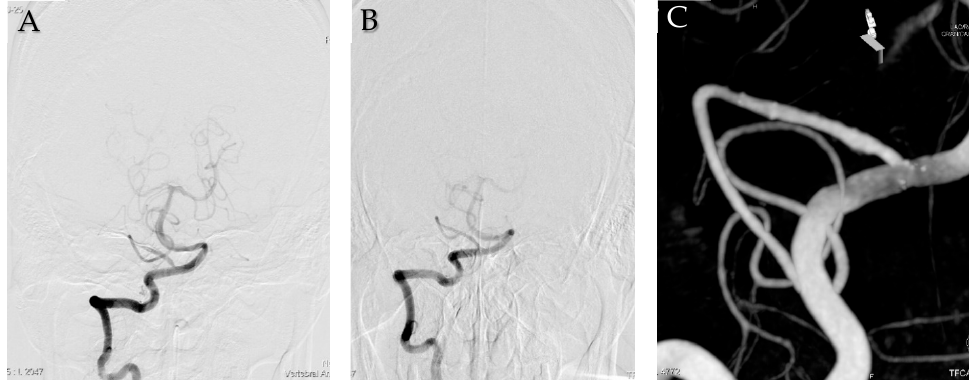
Figure 3. Follow-up cerebral angiography. Angiography showed an invisible dissecting aneurysm at 3 weeks later ( A ). Eight months later, Angiogram ( B ) and reconstructive image ( C ) showed complete remodeling of dissecting aneurysm. 3. Discussion